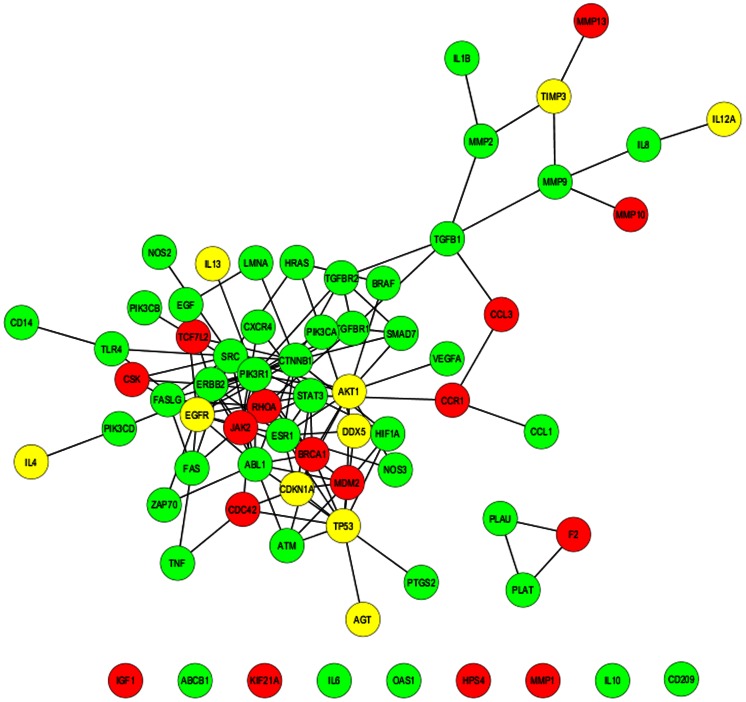
Fibrosis-related network of functional protein association that is regulated by miR-1 and miR-21.Red, green and yellow nodes represent proteins that are encoded by gene targeted by miR-1, miR-21 and both of them, respectively. TSSmiR-1:miR-21 = 0.169; PISmiR-:miR-21 = 1.029; synergy scoremiR-1:miR-21 = 2.021.